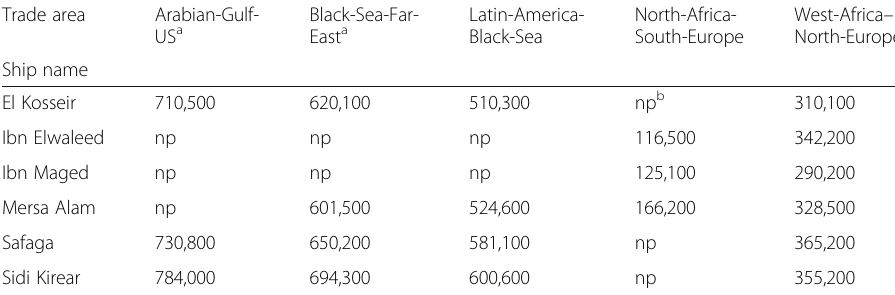
Table 12 The most-likely voyage gross profit (US$) in 2018, classified by ship and trade area Trade